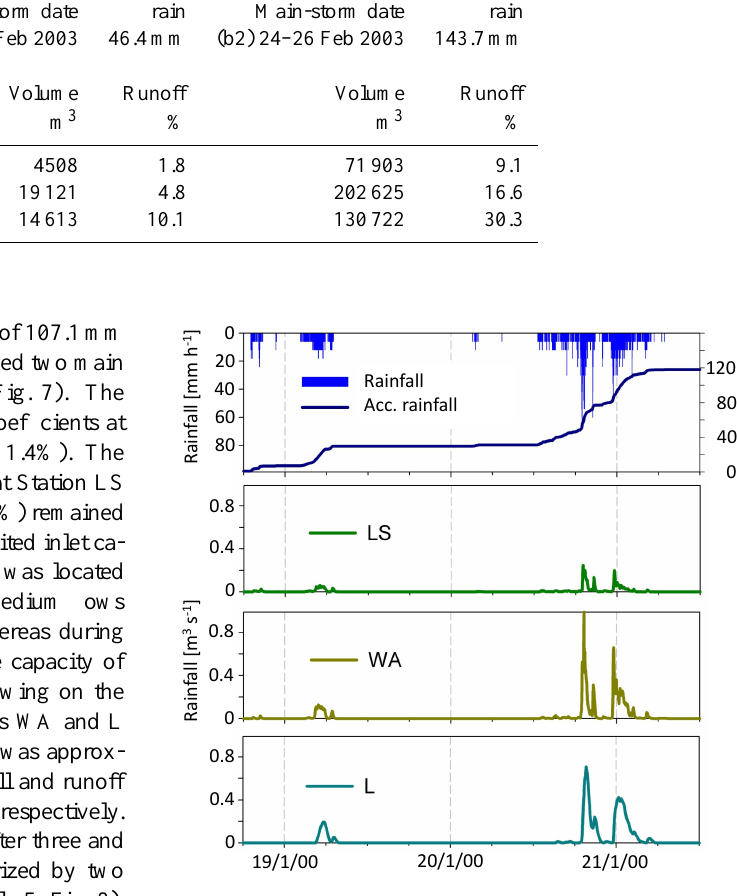
Fig. 7. The high-magnitude event measured at three gauging sta- tions in Ramallah. Note: rainfall is taken from valley